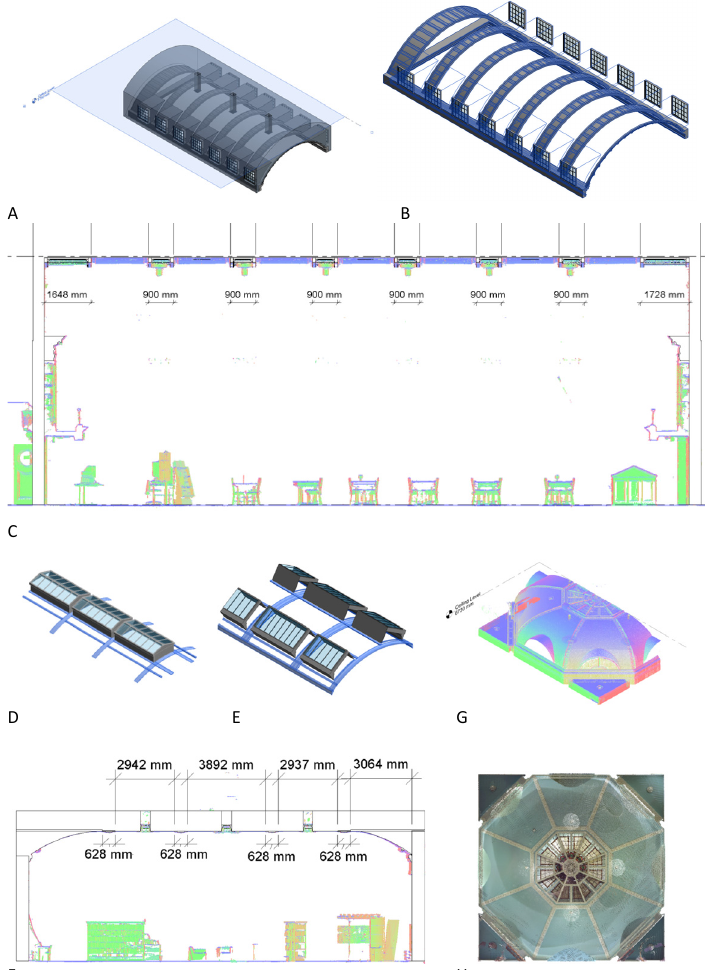
Figure 6. ( A – C ) Middlesbrough Library vaulted ceiling structure models and section ( D – F ) Possil Park Library rooflights and section (main reading room), ( G , H ) Loughborough Library ceiling orthophoto and model (main reading room).